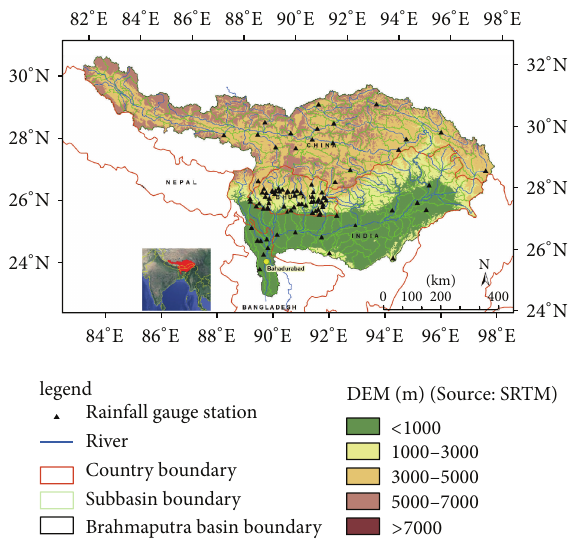
Figure 1: The Brahmaputra river basin (note: country boundary according to ESRI